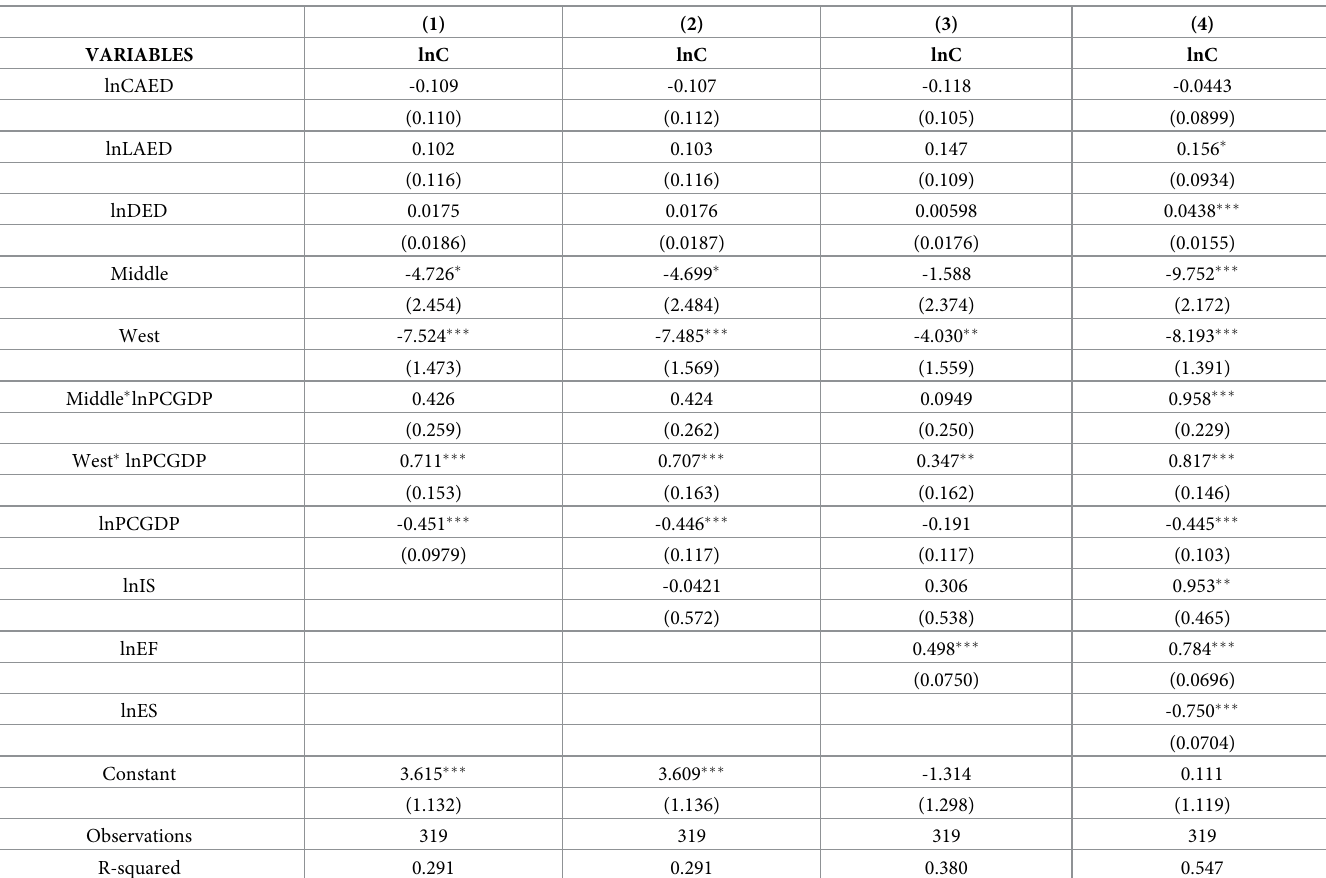
Table 4. Regression results of the pooled